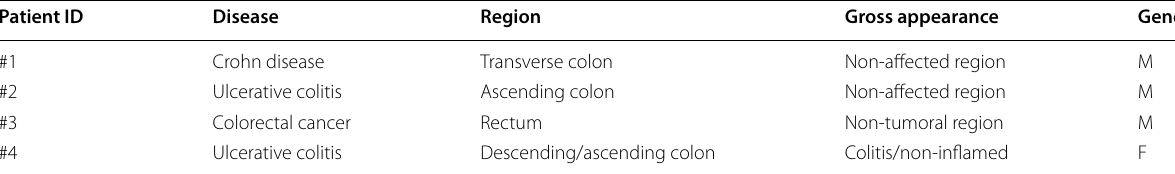
Table 2 Patient demographics: sample information is summarized in table Patient ID